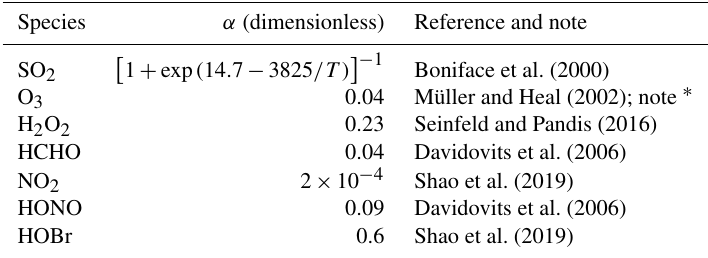
Table 3. Mass accommodation coefficients on aqueous surfaces.